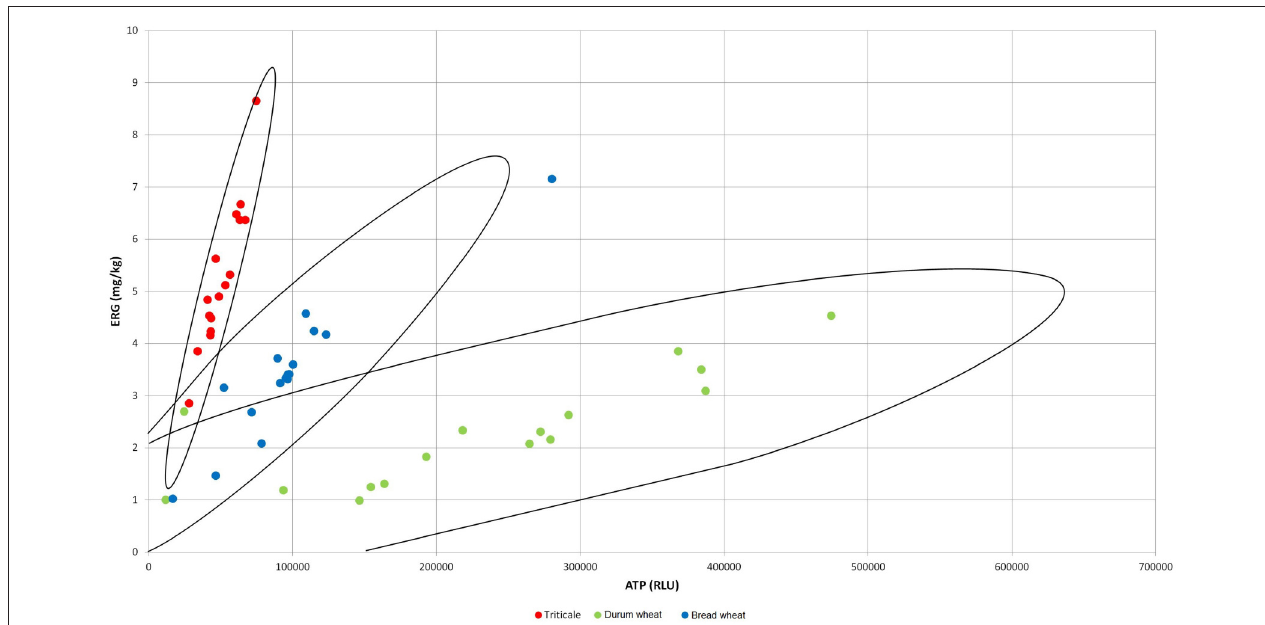
FIGURE 1 | Correlation between ERG concentration (mg/kg) and ATP level (RLU) for triticale, bread wheat, and durum